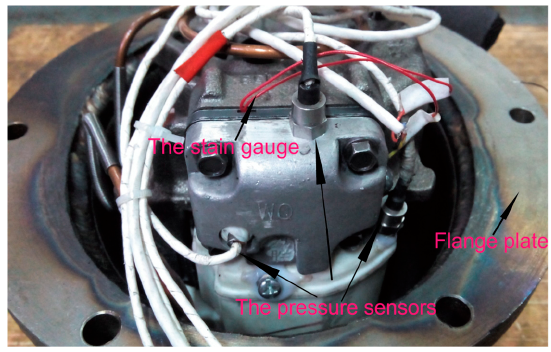
Table 2. The structural parameters of the refrigerator compressor.